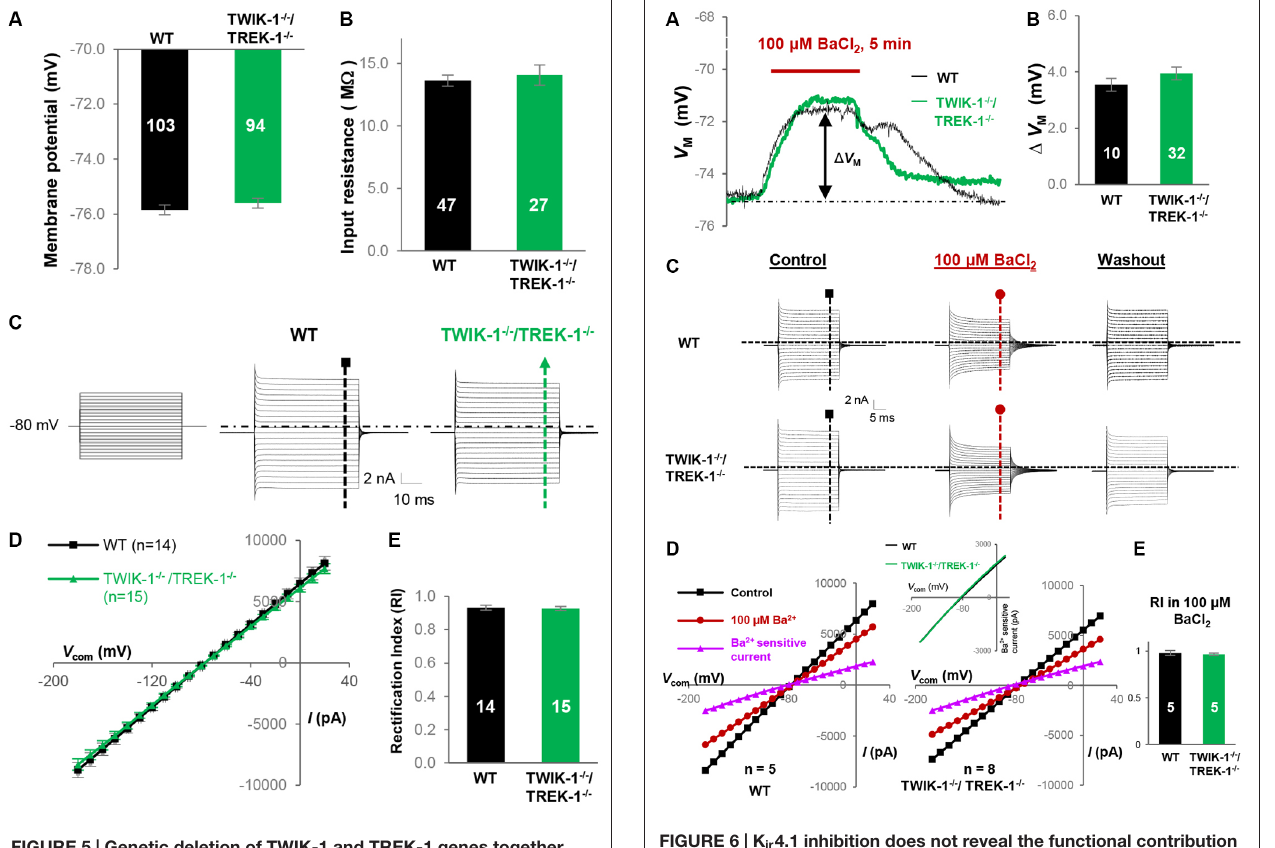
FIGURE 5 | Genetic deletion of TWIK-1 and TREK-1 genes together does not alter the electrophysiological properties of astrocytes. (A,B) Bar graph summary of the V M and R in from WT and TWIK-1 − / − /TREK-1 − / − astrocytes. (C) Representative whole-cell current profiles from WT and TWIK-1 − / − /TREK-1 − / − astrocytes, respectively. (D) Averaged I-V plots from these two genotypes, where the whole-cell current amplitudes in both inward and outward directions were comparable. (E) The RI values were also comparable between the two genotypes. ( Figure 1C ), 100 µ M BaCl 2 -induced V M depolarization was comparable between WT, 3.5 ± 0.23 mV ( n = 10), and TWIK-1 − / − /TREK-1 − / − astrocytes, 3.9 ± 0.23 mV ( n = 32;